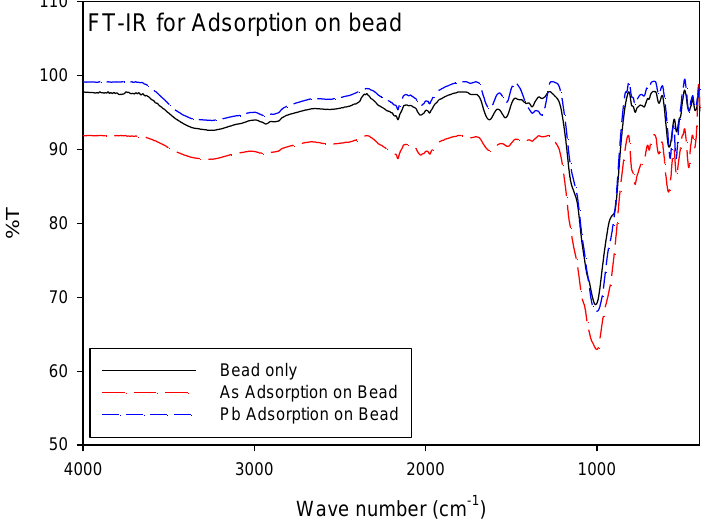
Figure 3. FT-IR spectra of the bead only; the As-loaded bead; and a Pb-loaded